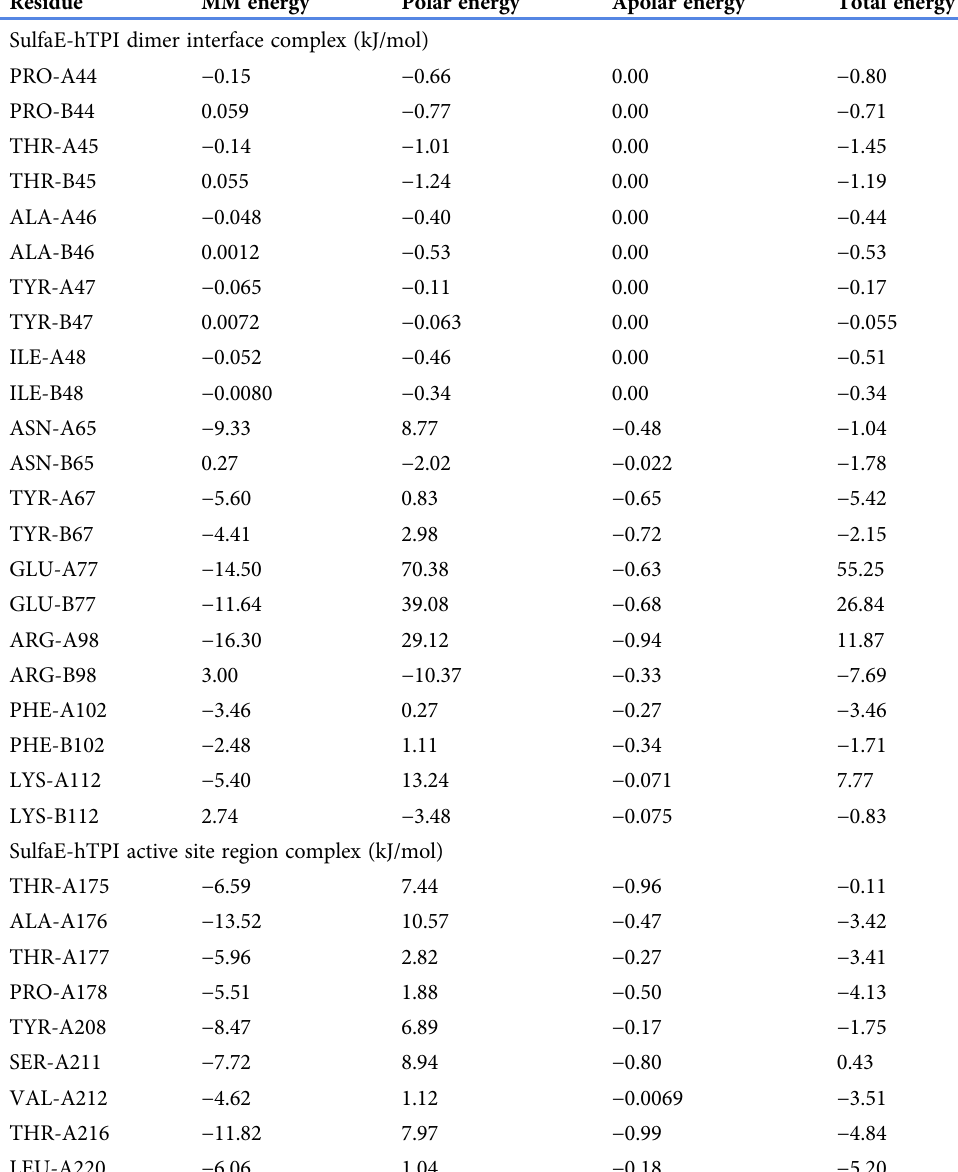
Table 5 Decomposition of binding free energies Δ G (kJ/mol) for the four SulfaE − hTPI complexes into contributions from individual